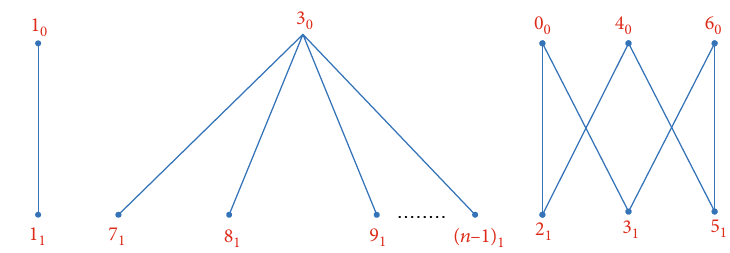
Figure 10: An orthogonal labeling for K